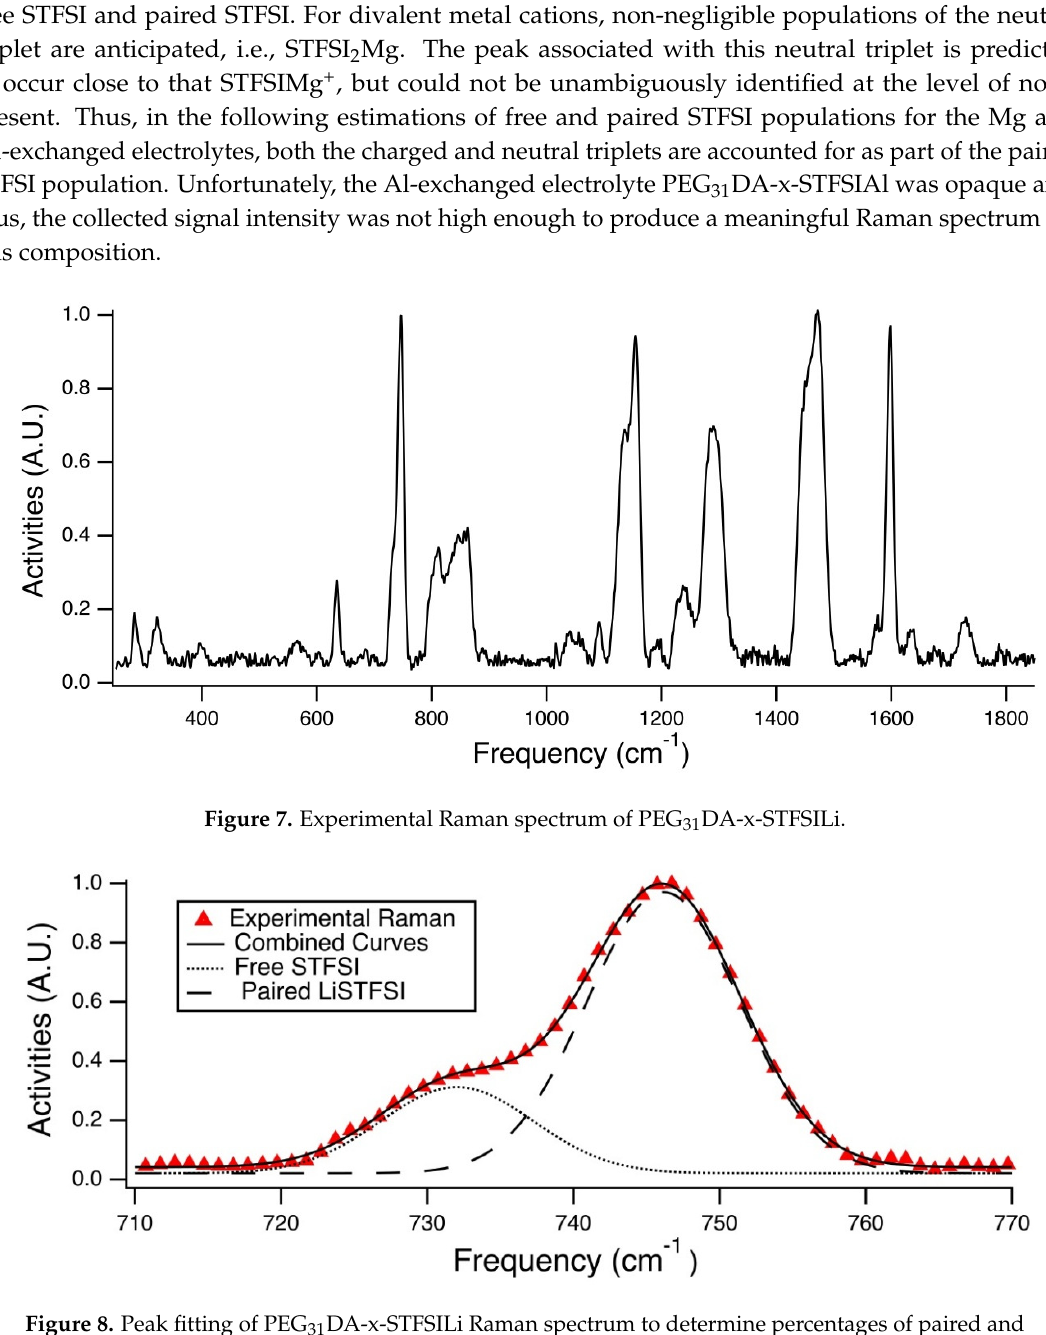
Figure 8. Peak fitting of PEG 31 DA ‐ x ‐ STFSILi Raman spectrum to determine percentages of paired and unpaired (free) anions. The spectra for films of other compositions appeared quite similar.